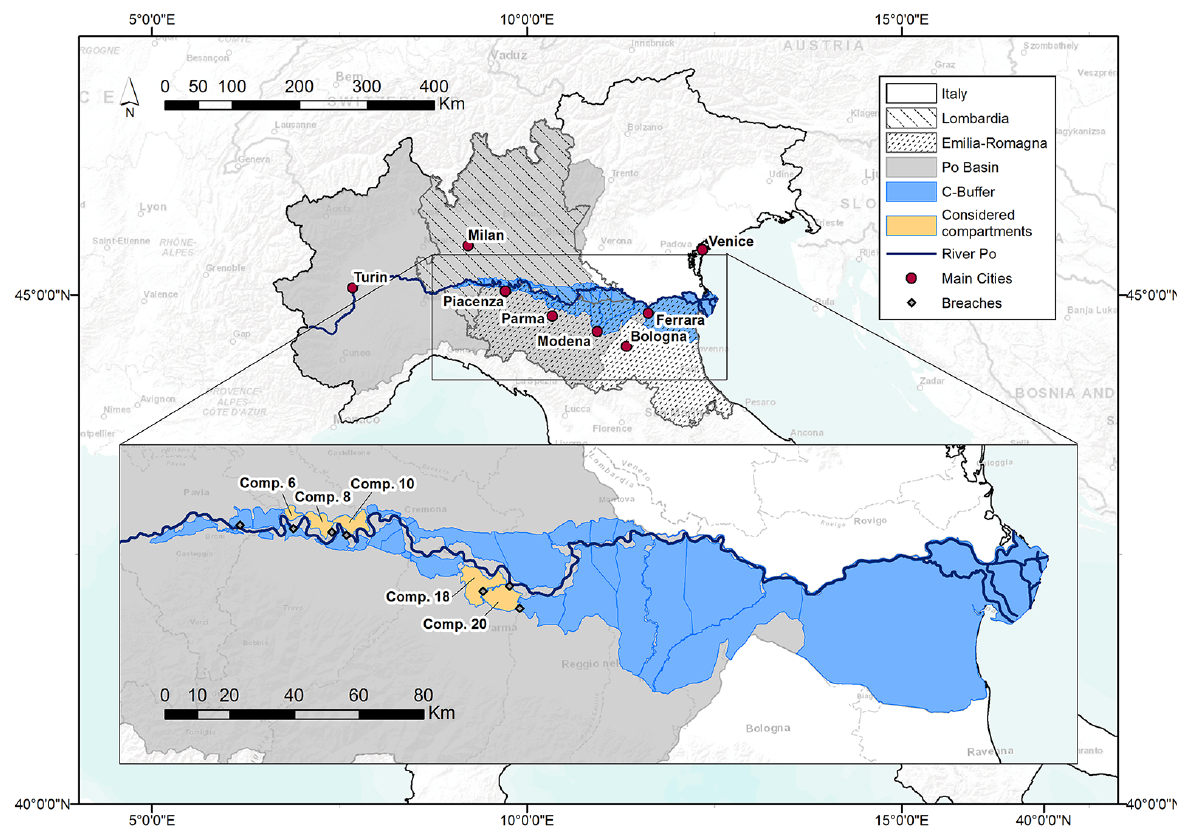
Figure 2. Study area: Po river basin and Regions of interests (Emilia-Romagna and Lombardy); the blue compartments (blue polygons) represent the area outside the levee system exposed to a residual flood risk (i.e. C-Buffer zone; AdB-Po,